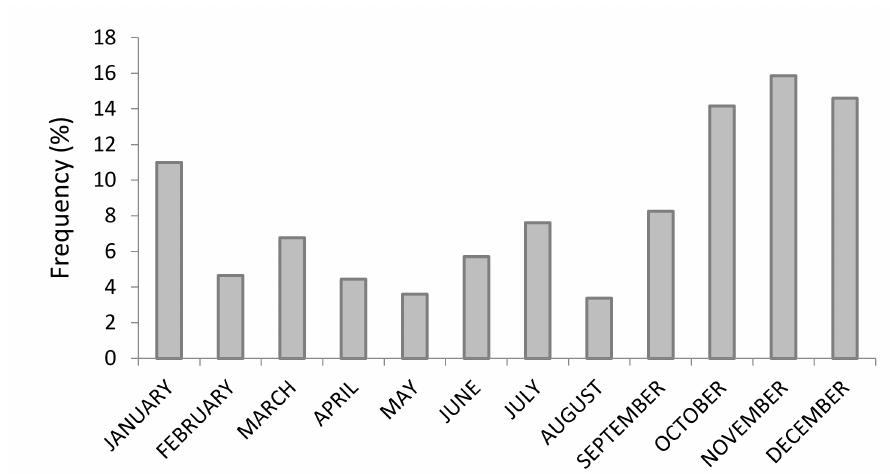
Figure 3. Distribution of calving events during the year. A total of 296 female calves (62.6%) and 177 male calves (37.4%) were born. Among the female calves, 189 were Holstein purebred. Overall, 48.8% of the calves born were Holstein, 30.0% of the calves were Belgian-blue crossbred, with smaller percentages of Limousin (9.1%), Wagyu (7.4%), and Angus (3.0%) crossbreds. The distribution of the Brix assessment of each dam’s colostrum, as reported in Figure 4, showed a right-shift, with most values ≥ 27% Brix.